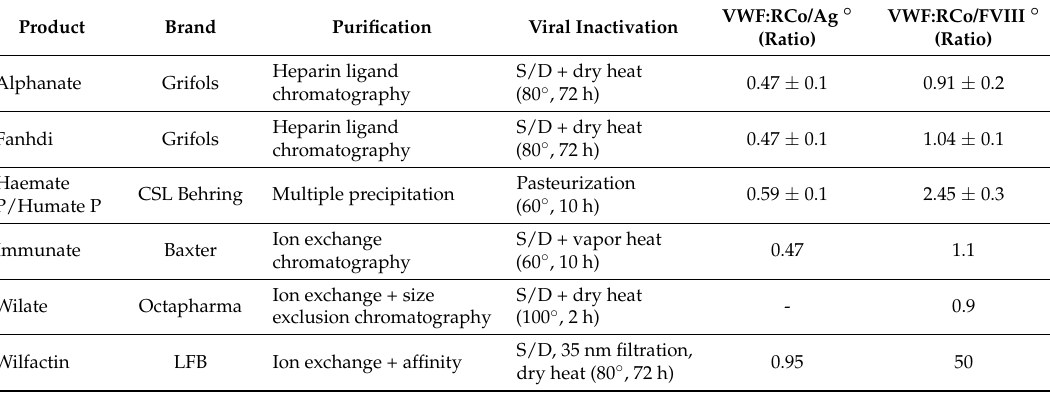
Table 3. VWF/FVIII concentrates licensed in Europe.